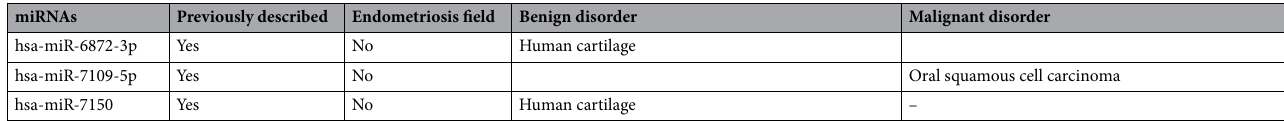
Table 4. Disorders previously associated with the miRNAs of the endometriosis—signature.